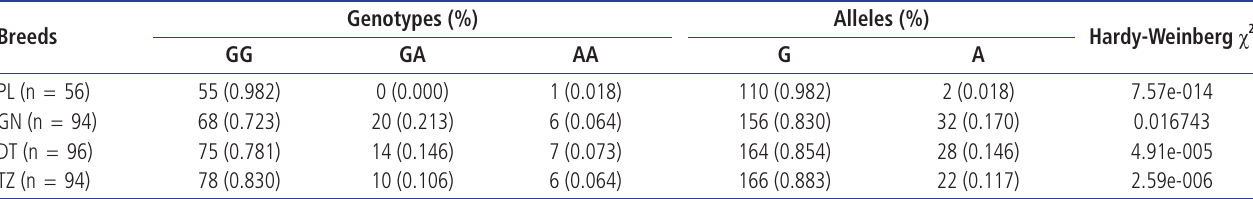
Table 3. Allele and genotype distribution of single-nucleotide polymorphism rs2381 A → G in the four yak breeds Genotypes (%) Alleles Breeds